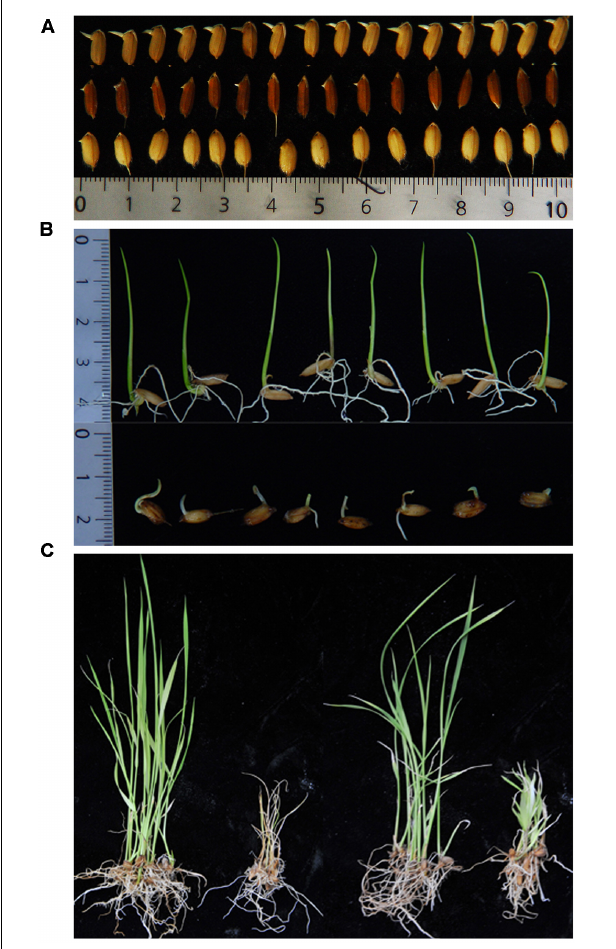
FIGURE 2 | Examples of the five chilling tolerance indices assessed in this study. (A) Low Temperature Germinability (LTG) measures the percent germination of seeds after 30 days of incubation at 10 ± 1 ◦ C. First row, ∼ 100% LTG; second row, ∼ 50% LTG; third row, ∼ 10% LTG. (B) Plumule Growth after Cold Germination (PGCG) measures the growth rate of young seedlings at 28 ± 1 ◦ C after 30 days of germination at 10 ± 1 ◦ C. The first row illustrates high PGCG and the second row low PGCG. (C) Low Temperature Seedling Survivability (LTSS, left two plants), measures the survivability of 2-week-old seedlings after 1 week of incubation at 10 ± 1 ◦ C and 1 week of recovery growth at 28 ± 1 ◦ C. ∼ 100% LTSS (far left) vs. ∼ 0% LTSS (second from left). Plumule Growth after Cold (PGC, right two plants) measures the ability to resume growth at 28 ± 1 ◦ C after 1 week of incubation at 10 ± 1 ◦ C. ∼ 100% PGC (2-fold increase; second from right) vs ∼ 0% PGC (green but no growth; far right).